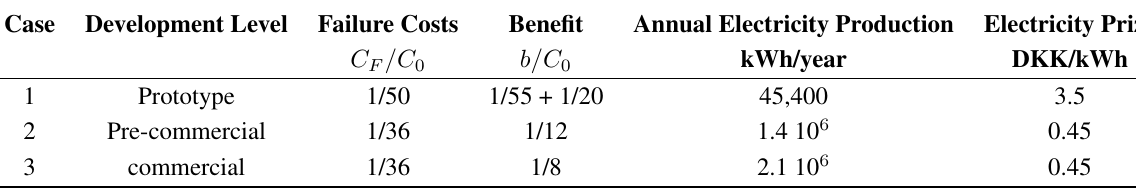
) for different development stages of the Wavestar concept. 0